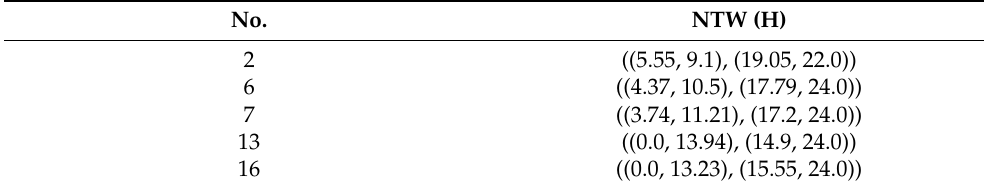
Table 10. Navigable time windows constrained by tidal height.